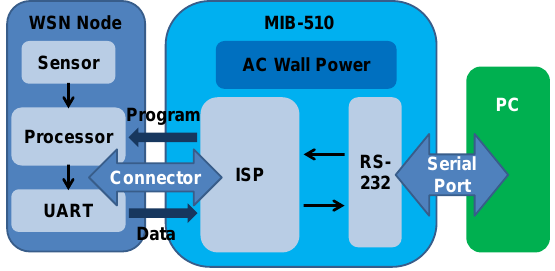
Figure 2: The architecture of MIB-510, and the MIB-600 is similar